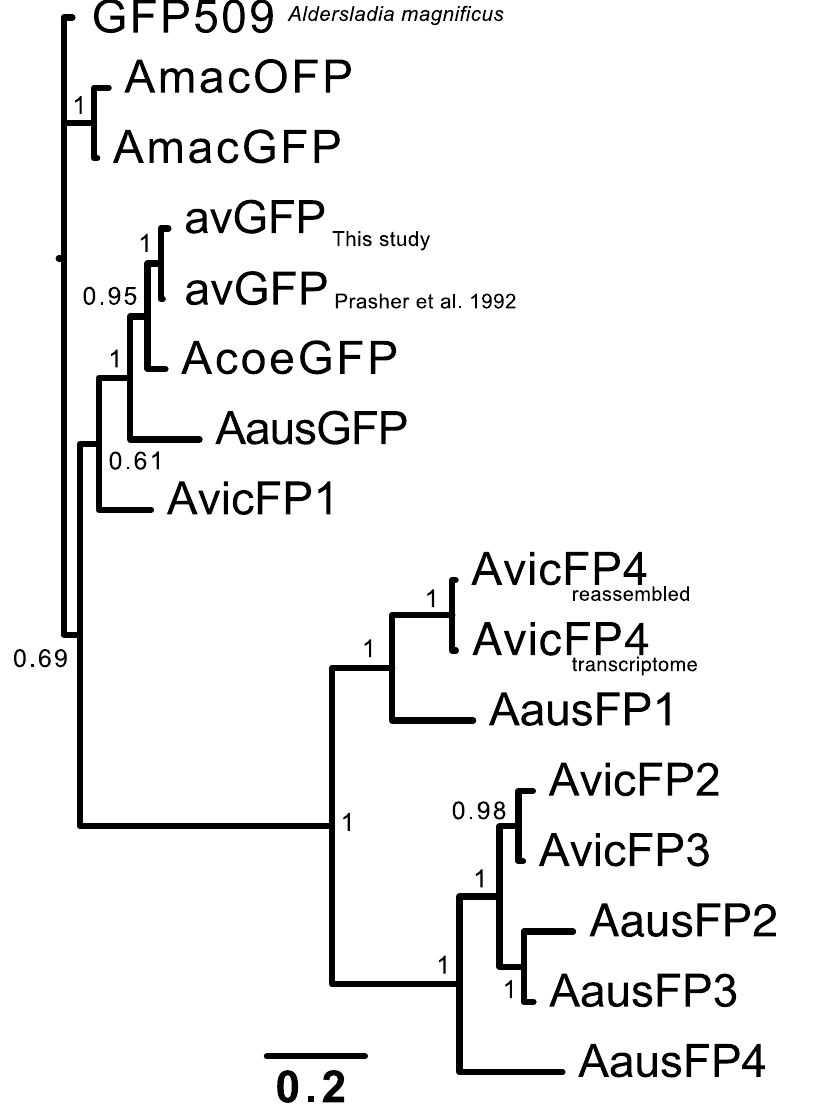
Fig 3. Phylogenetic tree for FPs cloned in this study, with Aequorea macrodactyla and Aldersladia magnificus green FPs included as outgroups. Green-emitting FPs with avGFP-like properties, including AvicFP1, fall into 1 cluster of fairly closely related sequences, while the novel fluorescent (AausFP1 and AvicFP4) and non-fluorescent homologs form 2 additional families. The data underlying this figure (nucleotide sequences of the FPs from this study) may be found in GenBank, accession numbers MN114103 through MN114112. avGFP, Aequorea victoria green fluorescent protein; FP, fluorescent